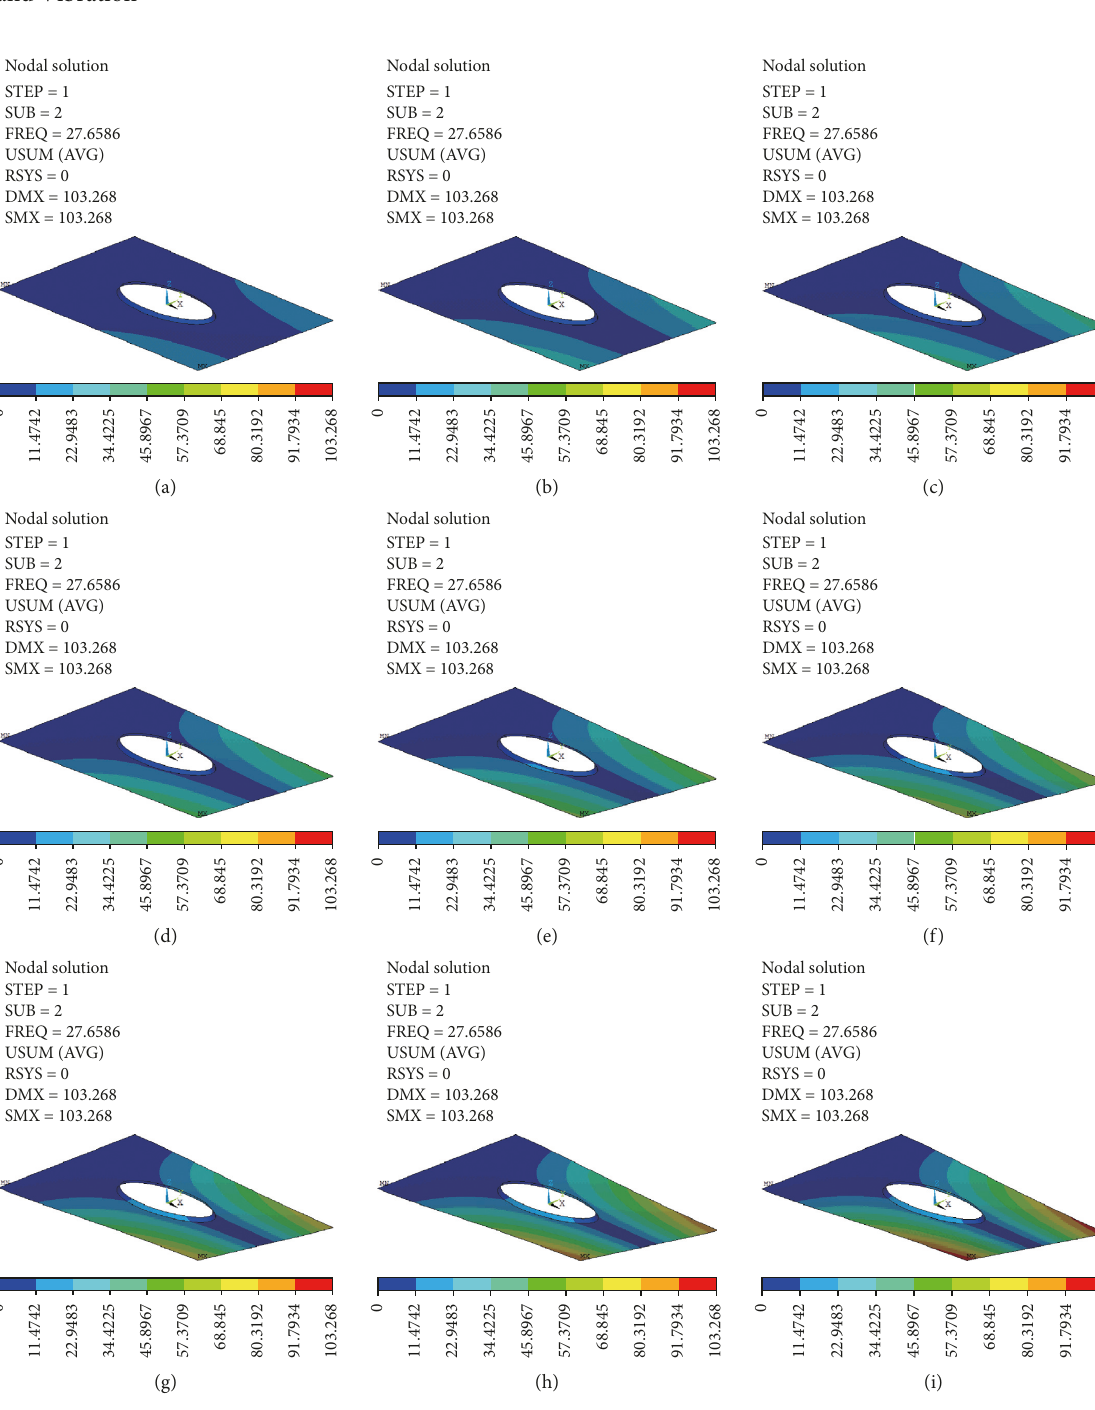
0.05. (b) Time (cid:31) (cid:31)